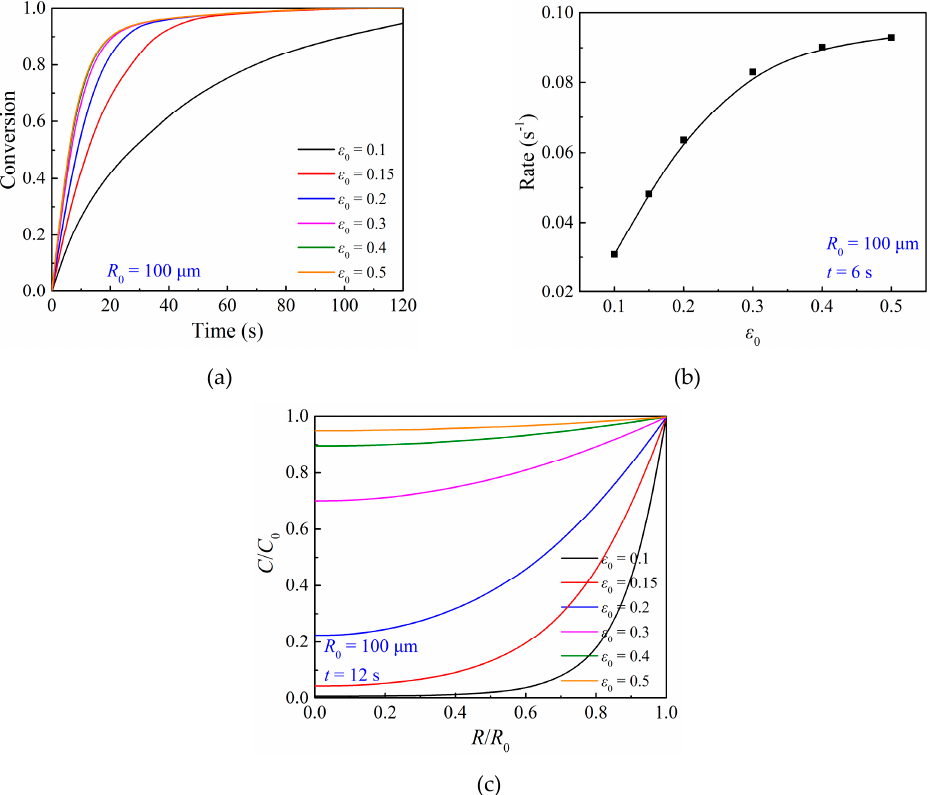
Figure 9. Effects of particle porosity on ( a ) the overall conversion of the particle, ( b ) reaction rate of the particle, and ( c ) oxygen concentration at R / R 0 = 0.5 during the oxidation reaction at 800 °C.